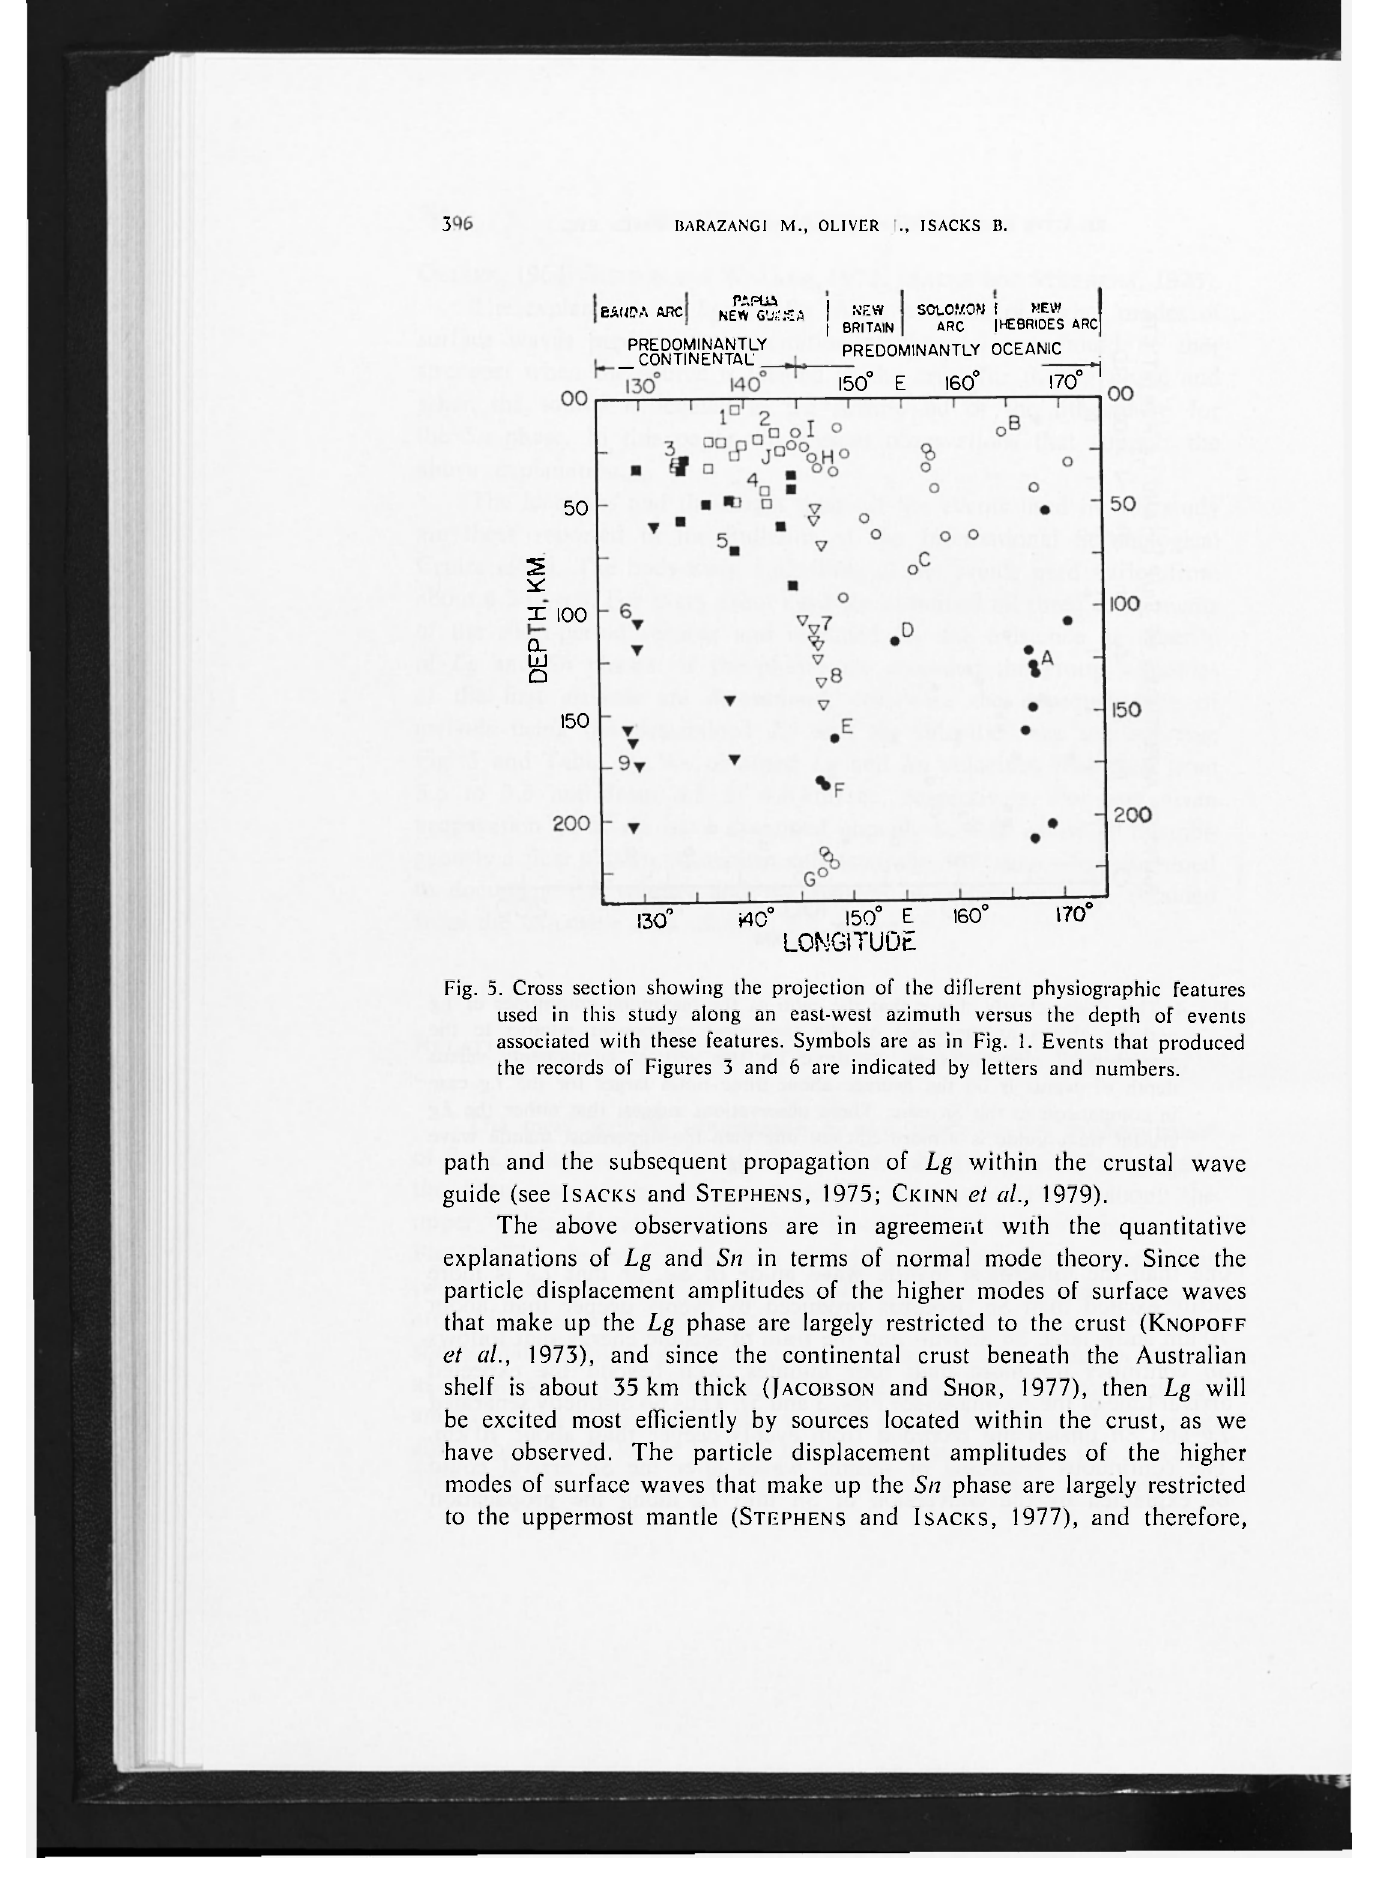
Fig. 5. Cross section showing the projection of the diflerent physiographic features used in this study along an east-west azimuth versus the depth of events associated with these features. Symbols are as in Fig. 1. Events that produced the records of Figures 3 and 6 are indicated by letters and